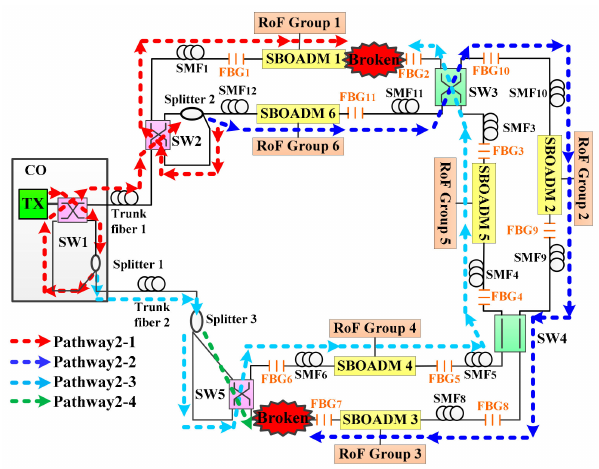
Figure 9. Routing pathways of the downstream detection signals during the execution of the first phase of the second step of the detection step.